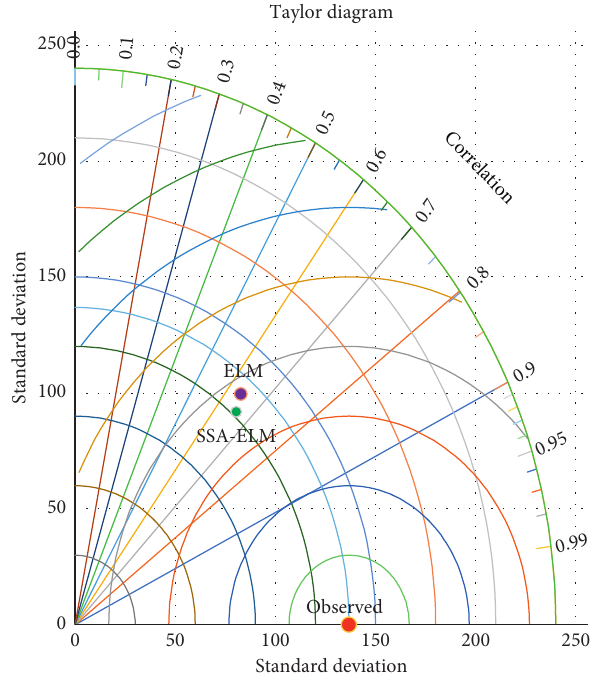
Figure 8: Taylor diagram graphical presentation for the ELM and SSA-ELM predictive models.